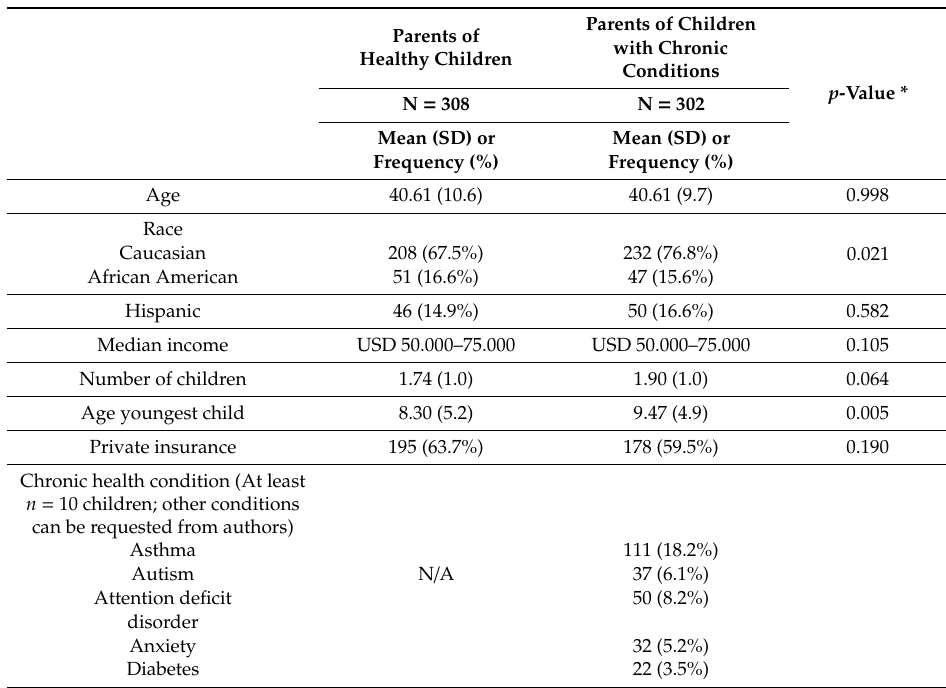
Table 1. Sample demographics.